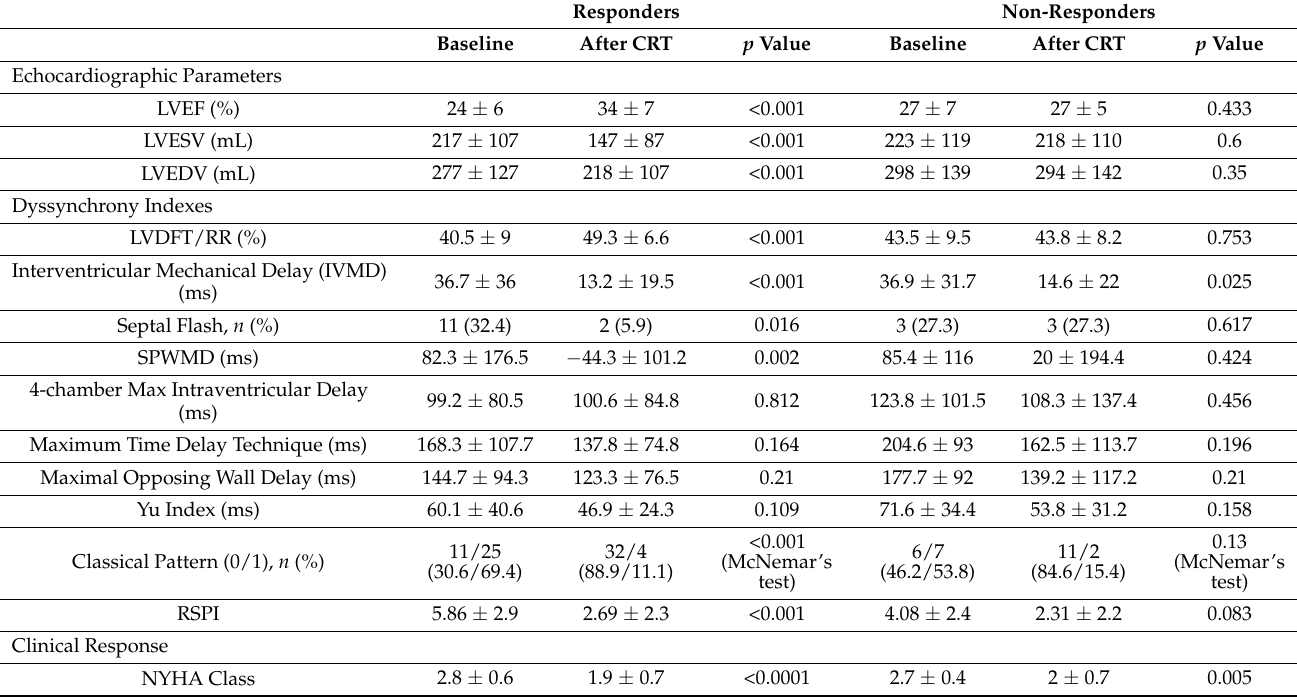
Table 2. Dyssynchrony indexes and NYHA class before and after CRT in responders and